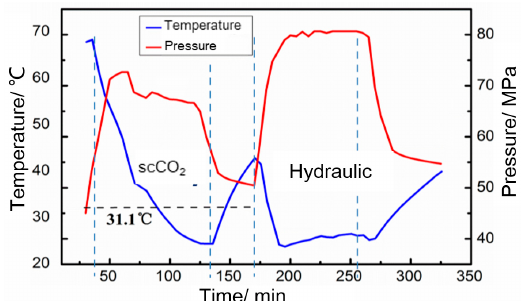
Figure 5. Bottom temperature and pressure monitoring results of Yan-A well during scCO 2 fracturing ( Adapted with permission from Ref. [44]. Copyright 2017, Yi Hu).